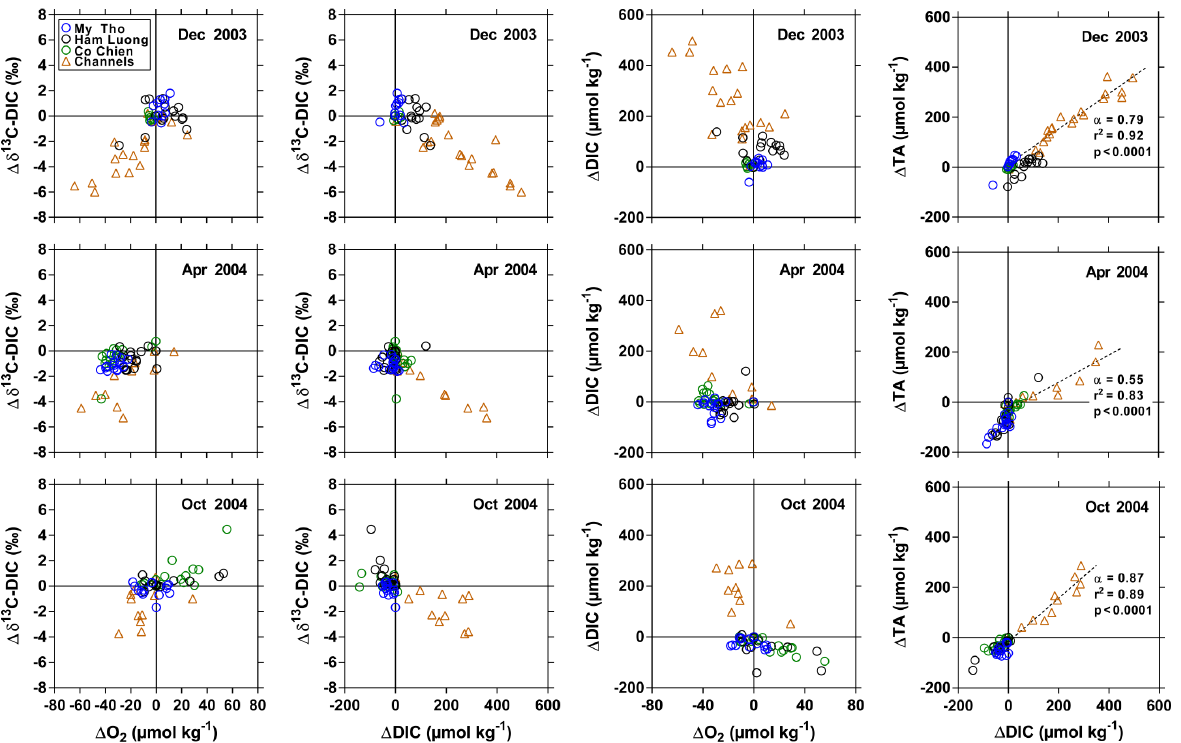
Figure 8. Deviations from conservative mixing lines of stable isotope composition of dissolved inorganic carbon (DIC) ( (cid:49)δ 13 C-DIC, ‰) as a function of O 2 ( (cid:49) O 2 , µmolkg − 1 ) and of DIC ( (cid:49) DIC, µmolkg − 1 ) , of (cid:49) DIC as a function of (cid:49) O 2 , and of total alkalinity ( (cid:49) TA, µmolkg − 1 ) as function of (cid:49) DIC in the three branches of the Mekong delta (M e y Tho, Hàm Luông, and C ´ˆ o Chiên) and side channels in December 2003, April 2004, and October 2004. α indicates the slope of the linear regression line (dotted